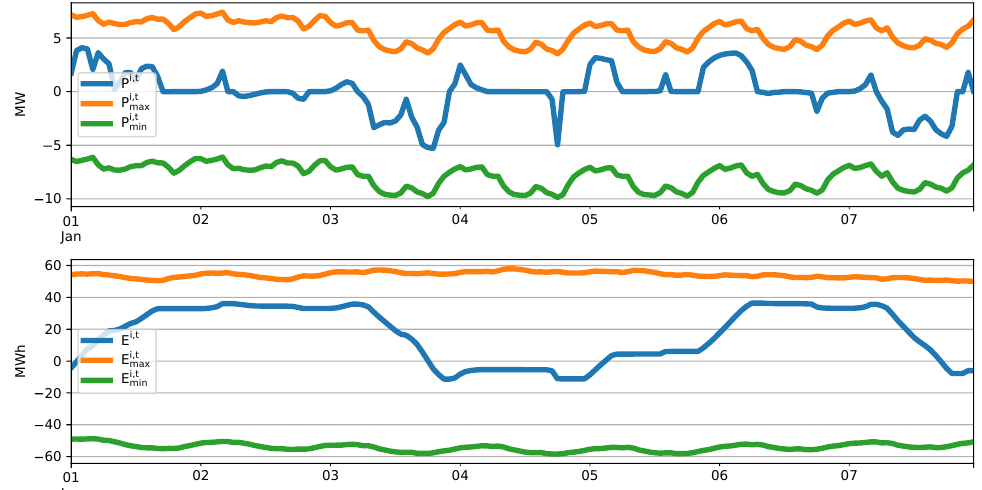
Figure 7. Time series for the optimised DR dispatch, P i , t , the maximum load increase, P i , t max , and load decrease, P i , t ( top row ) and the time series for the resulting filling level of the storage-equivalent min DR operation, E i , t , the maximum energy preponing, E i , t max , and energy postponing, E i , t row ), both for the example of a transmission grid node near the city of Dortmund in the first week of the